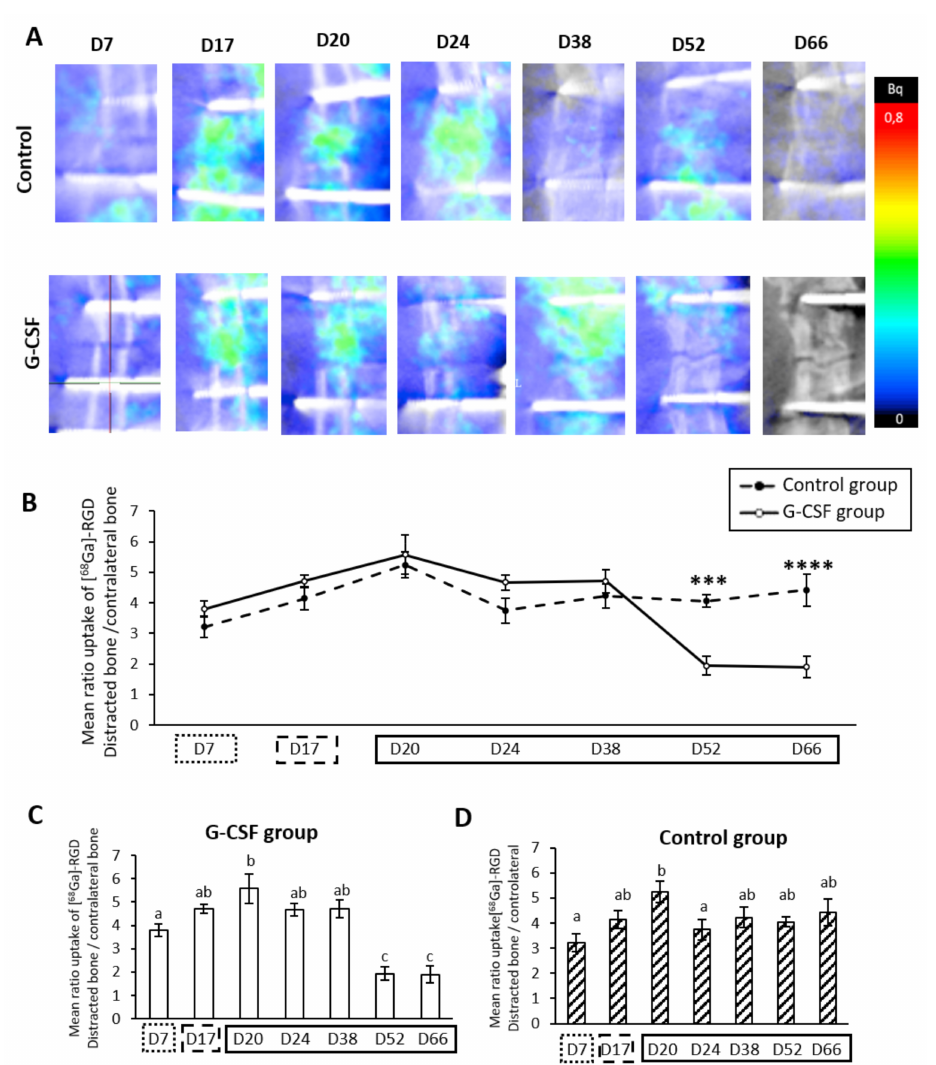
Figure 3. Course of vascularization metabolism during distraction osteogenesis (DO). ( A ) Representative positron emission tomography (PET) imaging 7, 17, 20, 24, 38, 52 and 66 days after surgery. ( B ) The temporal pattern of the mean uptake ratio of [ 68 Ga]-RGD is presented and demonstrates vascular metabolism inside the new regenerate. The dotted line represents the control group and the filled line represents the G-CSF group. ( C ) In the G-CSF group, the mean ratio peaks at D20 compared to D7 ( p = 0.007) and drops significantly at the end ( p = 0.0001). ( D ) In the control group, a peak at D20 is also shown compared to D7 ( p = 0.003) but only there is only a drop at D24 compared to D20 ( p = 0.05). A PET study was performed on 6 control animals and 4 G-CSF animals. a, b, c: if two means share the same letter, no statistical differences were found. represent the latency period, the distraction phase is represented by , and